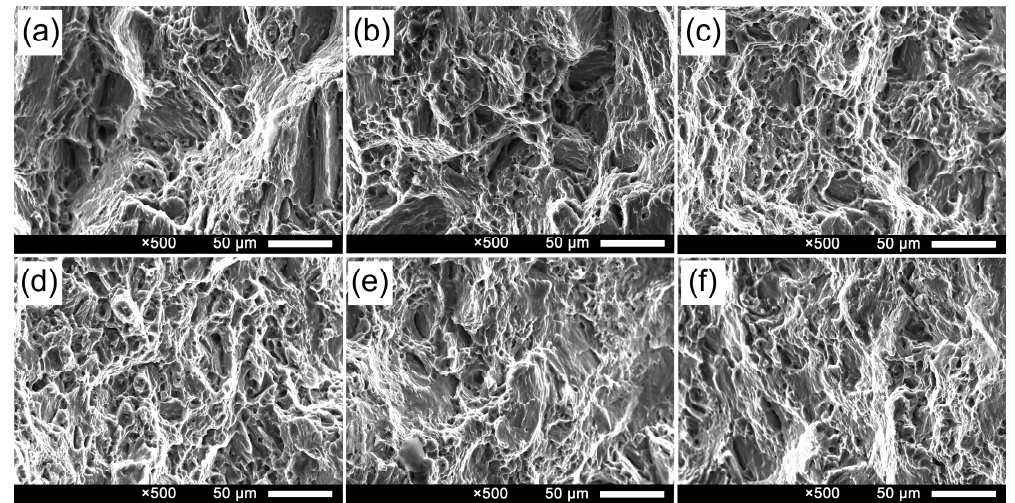
Figure 10. SEM fractographs of tensile samples deposited by different pulse frequencies: ( a ) 500 Hz; ( b ) 100 Hz; ( c ) 10 Hz; ( d ) 5 Hz; ( e ) 2 Hz and ( f ) 1 Hz.